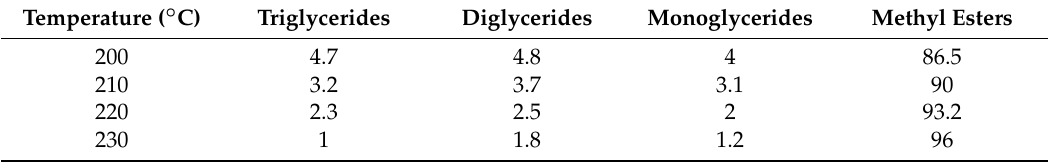
Table 3. Effect of temperature on the transesterification with catalyst TiO 2 /SO 42 − (%, w). Temperature ( ◦ C) Triglycerides Diglycerides Monoglycerides Methyl Esters